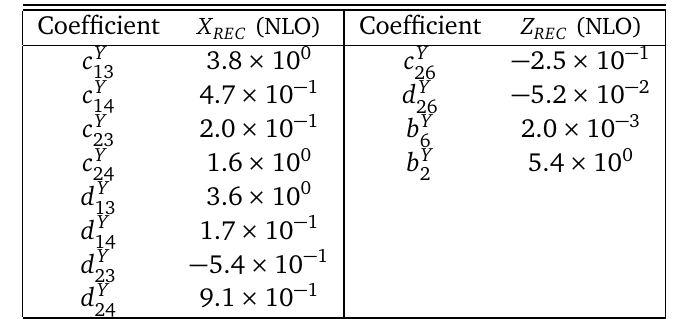
Table 6: Coefficients for the LM with the LO-inspired basis expressed in Eqs. (41) and (42) for both x and z momentum